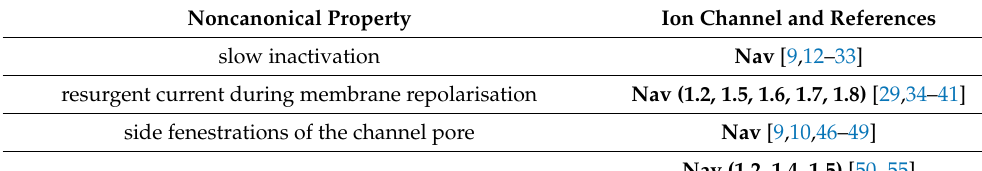
Table 1. Overview for the mentioned noncanonical ion channel features: canonical features not discussed in the review are considered ligand- and voltage-gating, selective permeability, interaction with other proteins, fractional presence at the plasma membrane, heteromerisation, modulation by intracellular cascades, and a change of